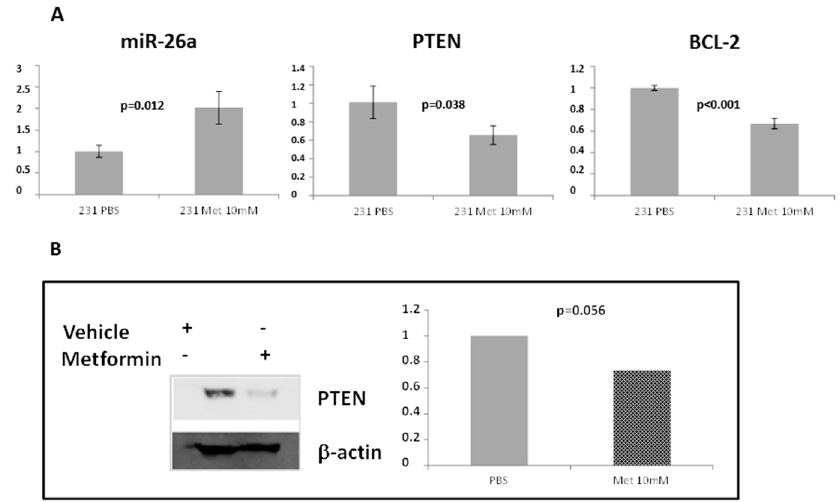
Figure 7. ( A ) Expression of miR-26a and two of its targets in MDA-MB-231 measured by RT-qPCR four days after treatment with 10 mM metformin or vehicle (PBS). Error bars represent triplicate experiments; ( B ) PTEN protein expression measured by Western blot. MDA-MB-231 was treated with 10 mM metformin or PBS, and β -actin was used as a control.